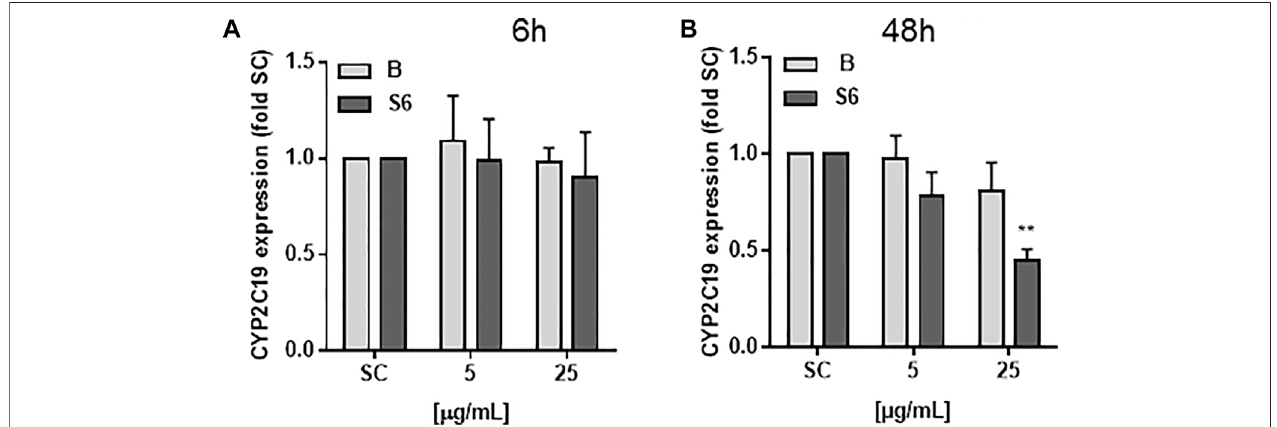
FIGURE2| mRNAlevelsofCYP2C19indifferentiatedHepaRGcellsafter Salix cortexextractstreatment.mRNAlevelswerequanti fi edbyqRT-PCR.Differentiated HepaRGcellsweretreatedwith Salix cortex extracts(extract BorS6) by6 h (A) or 48 h (B) .CYP2C19 expression levelswereexpressed asmean+SD;( n (cid:1) 3;S6,48 h n (cid:1) 2). Ordinary one-way ANOVA was used for statistical analysis, followed by a Dunnett test versus solvent control (SC: 0.5% destilled water) group. ** p <